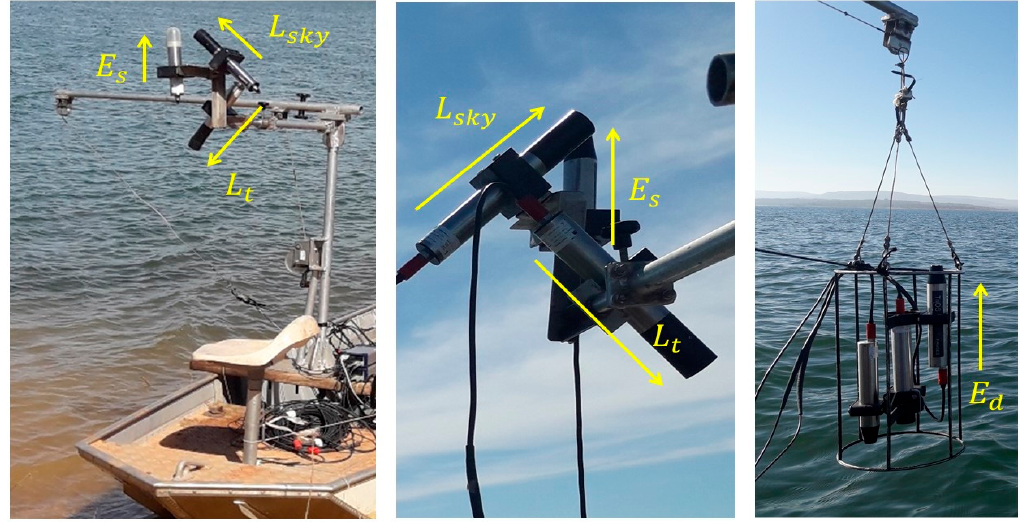
Figure 3. Field radiometric measurements framework scheme.